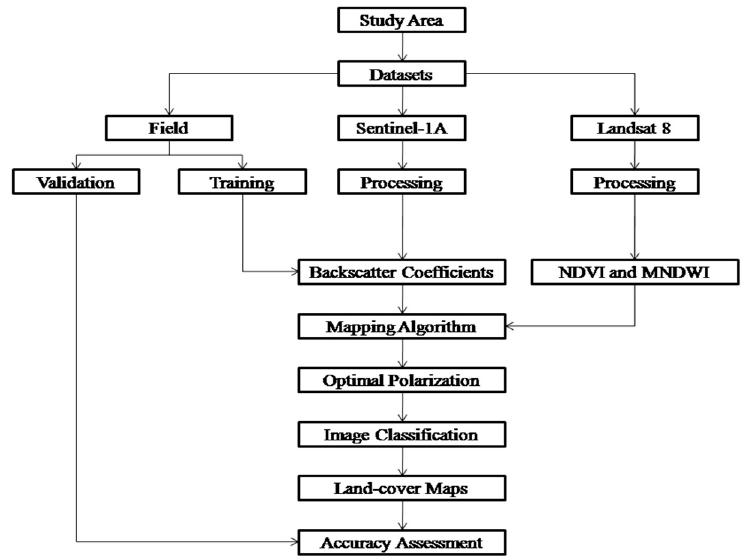
Figure 3. Methodological workflow.